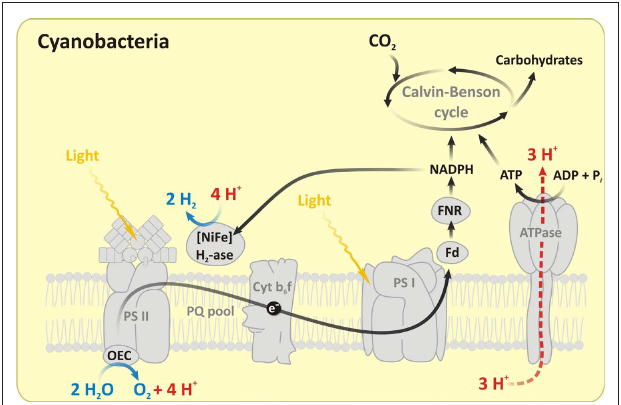
FIgurE 13 | A schematic representation of H photoproduction pathway 2 catalyzed by a hydrogenase in cyanobacteria. As in green algae, photosynthetic electron transport delivers electrons after light-induced water-splitting at the OEC to the hydrogenases (H -ase), leading to 2 photophosphorylation and H production. In addition to hydrogenases, 2 nitrogenases are also known to produce H in oxygenic cyanobacteria and in 2 anoxygenic purple bacteria. Abbreviations: PQ, plastoquinone; Fd, ferredoxin; FNR, ferredoxin–NADP reductase; ATPase, adenosine triphosphate. The figure is modified and adapted from Shevela and